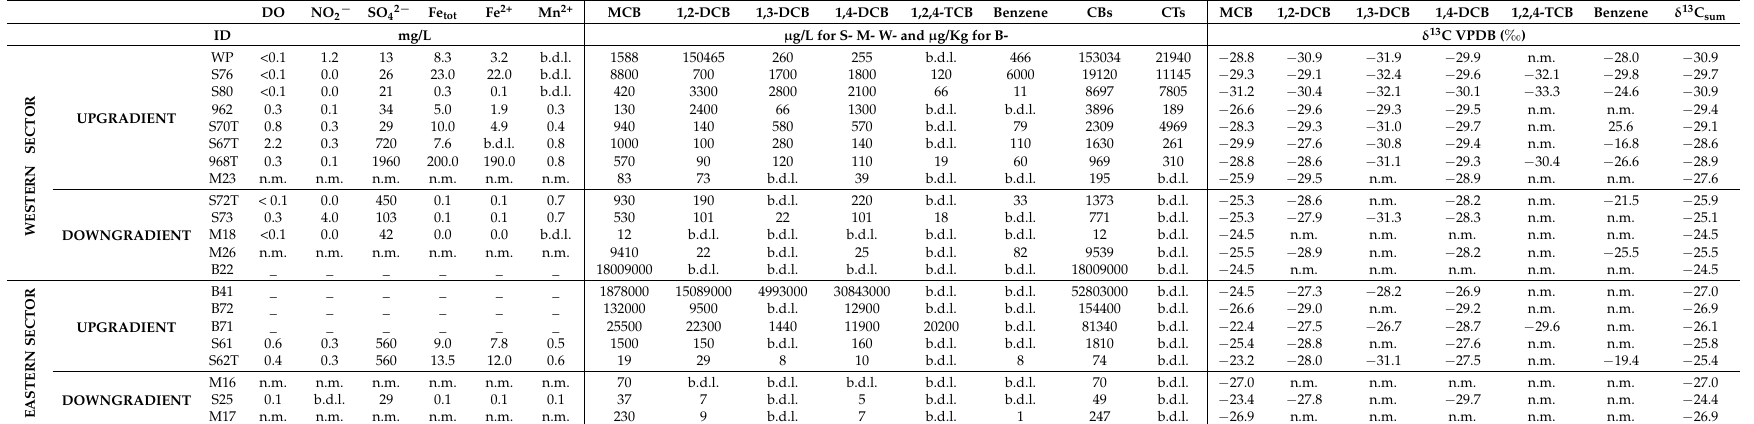
Table 1. Data summary. Redox species (mg L − 1 ) and chlorobenzenes (CBs) and chlorinated toluenes (CTs) concentrations ( µ g L − 1 and µ g kg − 1 for groundwater and soil samples, respectively); isotope data ( ‰ ): δ 13 C and δ 13 C sum . See Figure 2 for sample